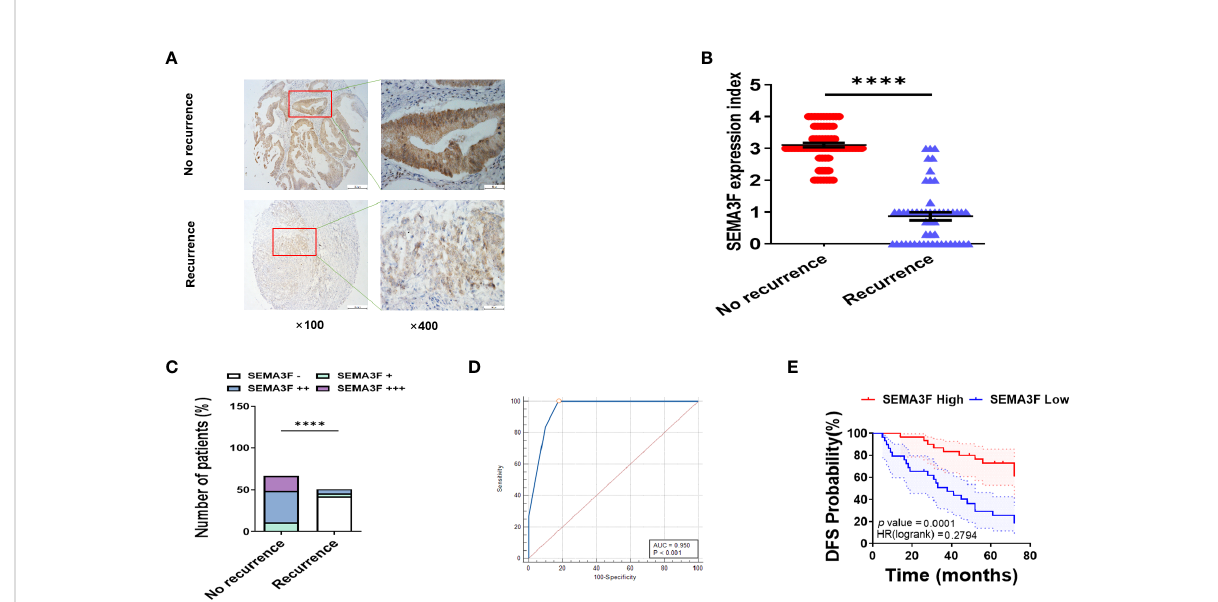
FIGURE 6 CRC patients with high SEMA3F expression are more sensitive to 5-Fu chemotherapy than patients with low expression. (A) Immunohistochemical staining of SEMA3F was carried out in tissues from patients with recurrent CRC and patients with no recurrence. (B) The SEMA3F expression indexes in the recurrence and no recurrence groups are shown (****P<0.0001). (C) Statistical analysis of immunohistochemical staining data for SEMA3F in patients with recurrent and nonrecurrent CRC (****P<0.0001). (D) ROC curve reveals that SEMA3F expression is a predictor for 5-Fu sensitivity. (E) Statistical analysis of 6-year disease-free survival in patients with high SEMA3F expression and low SEMA3F expression (HR=0.28, 95% CI: 0.14-0.56,